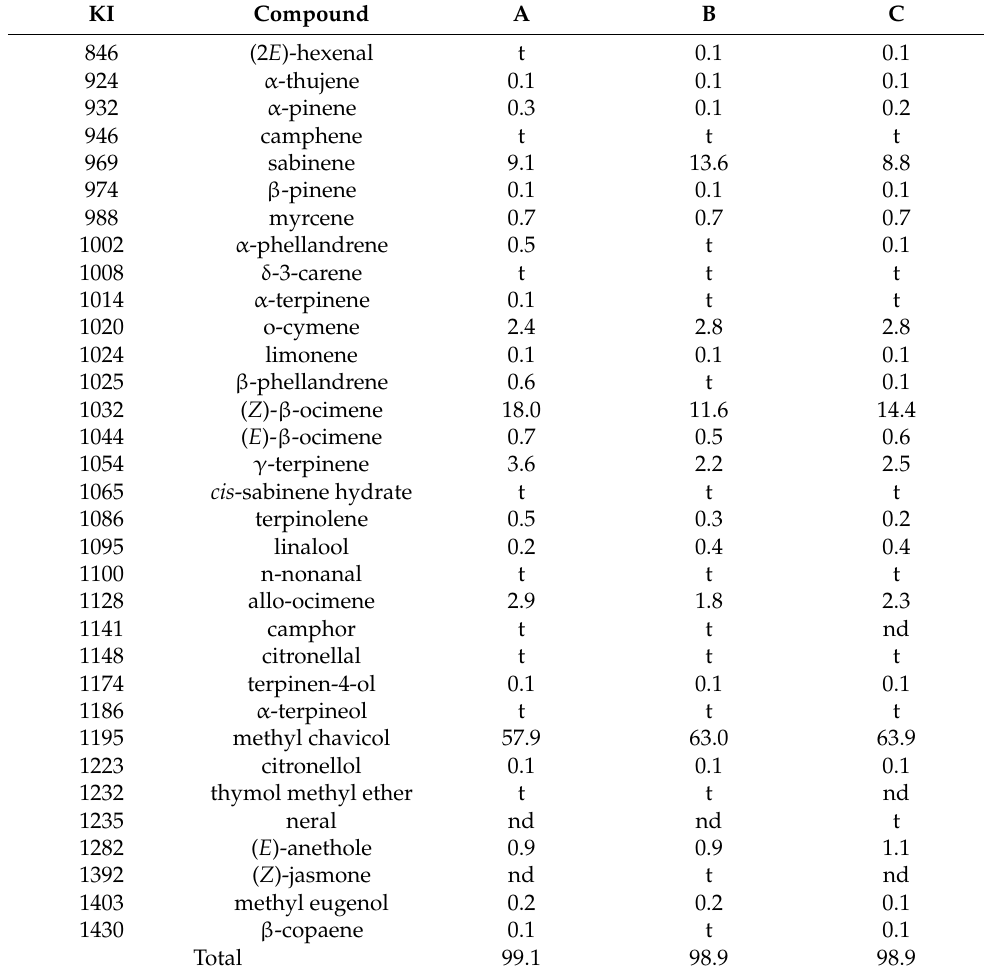
Table 2. Aromatic profile of Osmorhiza occidentalis essential oil samples A–C. Reported values below represent averages from samples analyzed in triplicate, which was done to ensure repeatability (standard deviation ≤ 1 for all compounds). Values less than 0.1% are denoted as trace (t) and those not detected in that sample as nd. Unidentified compounds less than 0.1% are not included. KI is the Kovat’s Index value and was previously calculated by Robert Adams using a linear calculation on a DB-5 column [31]. Relative area percent was determined by GC/FID.